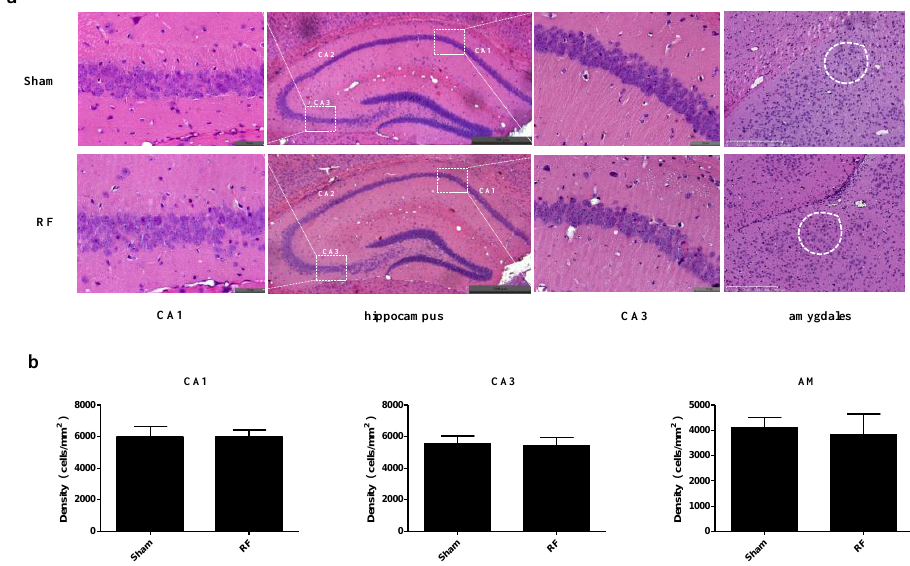
Figure 7. Effects of RF field exposure on the histology of brain. ( a ) The histology of hippocampus (CA1, CA3) and amygdala (AM) examined by HE staining. ( b ) The morphometry analysis of CA1, CA3 and AM (CA1: t = 0.156, df = 18, P = 0.878; CA3: t = 0.545, df = 18, P = 0.593; AM: t = 1.000, df = 18, P = 0.333). Enlargements (CA1: scale bar, 50 μm; hippocampus: scale bar, 500 μm; CA3: scale bar, 50 μm; amygdala: scale bar, 250 μm;) No significant difference was observed between the sham and RF groups ( P > 0.05).